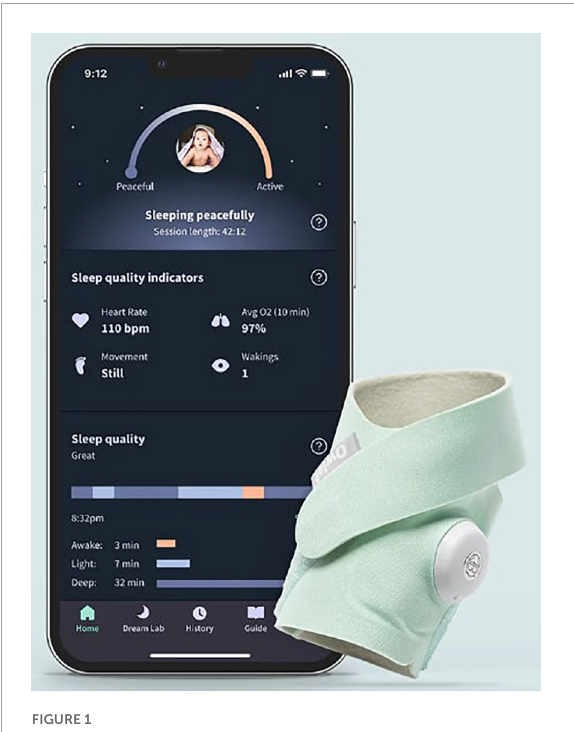
FIGURE1 Example of a wearable home pulse oximetry baby monitor and associated mobile application. With copyright permission from Owlet Baby